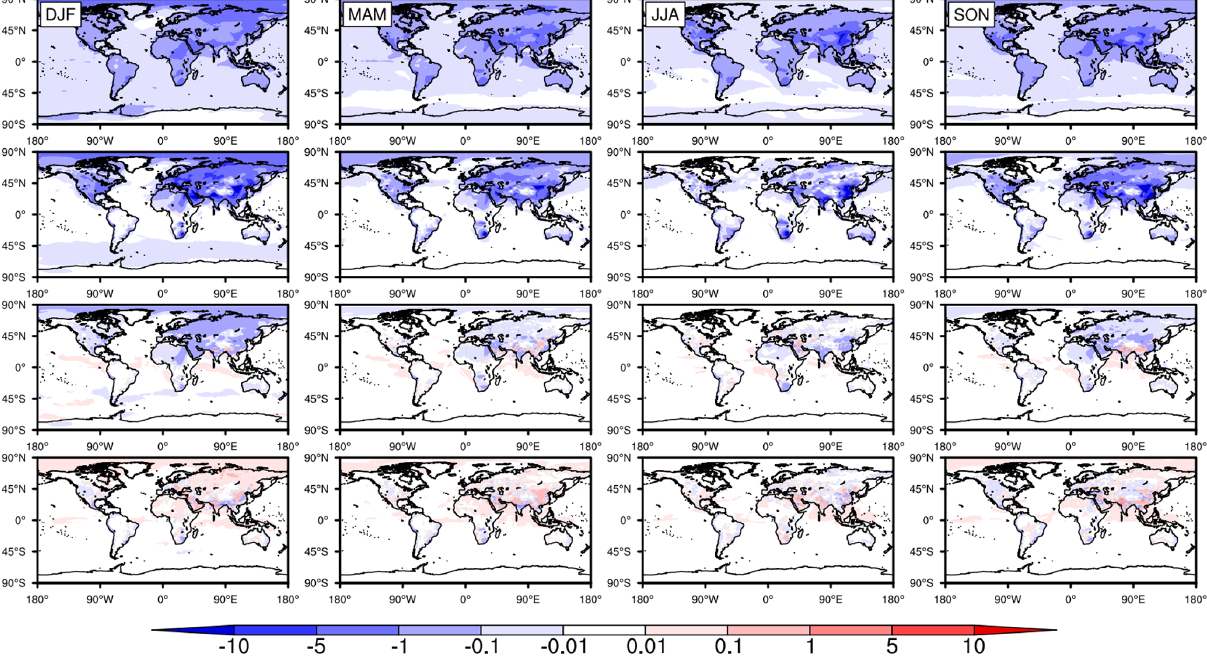
Figure 5. The differences in global seasonally averaged surface SO 2 mixing ratios (ppbv) in 2015 with the incorporation of HO x chemistry, Fe chemistry, N chemistry, and carbonate chemistry individually from top to bottom,